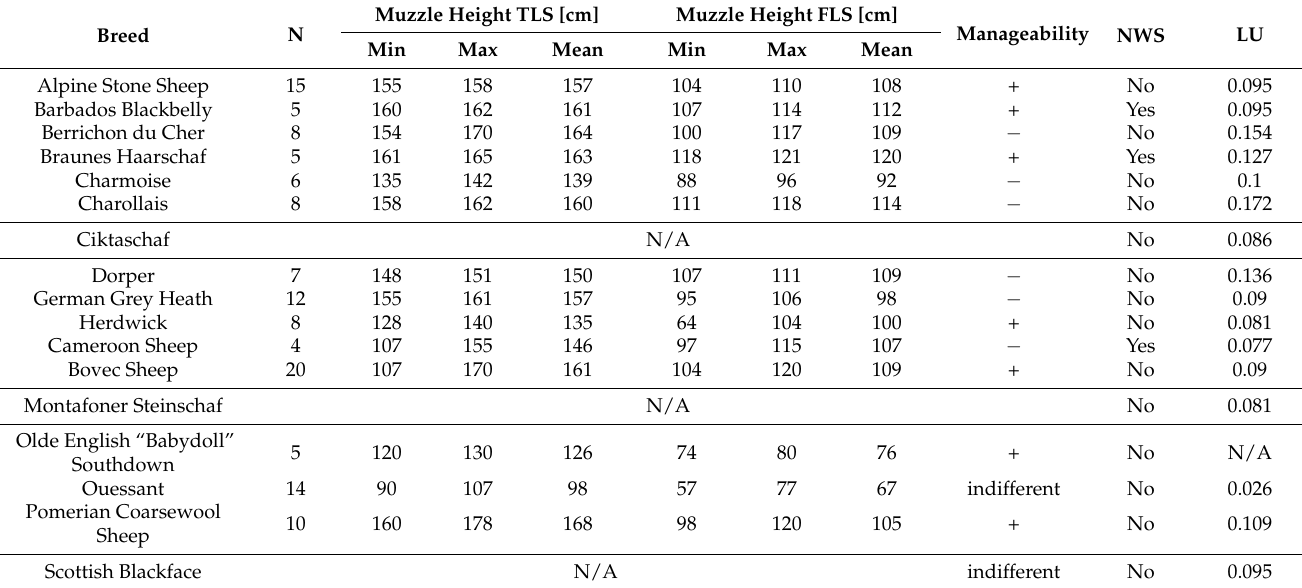
Table 3. Results of the survey of phenotypic